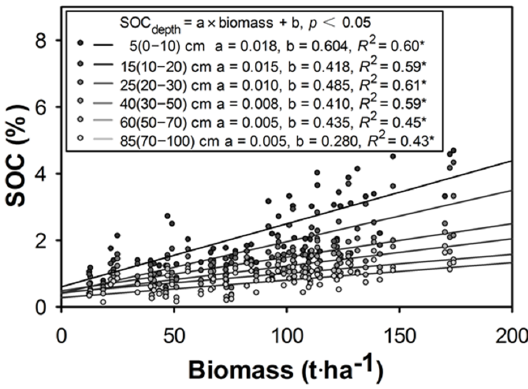
Figure 6. Correlations between SOC contents (%) at different levels of the soil profiles and the aboveground biomasses of the forests.